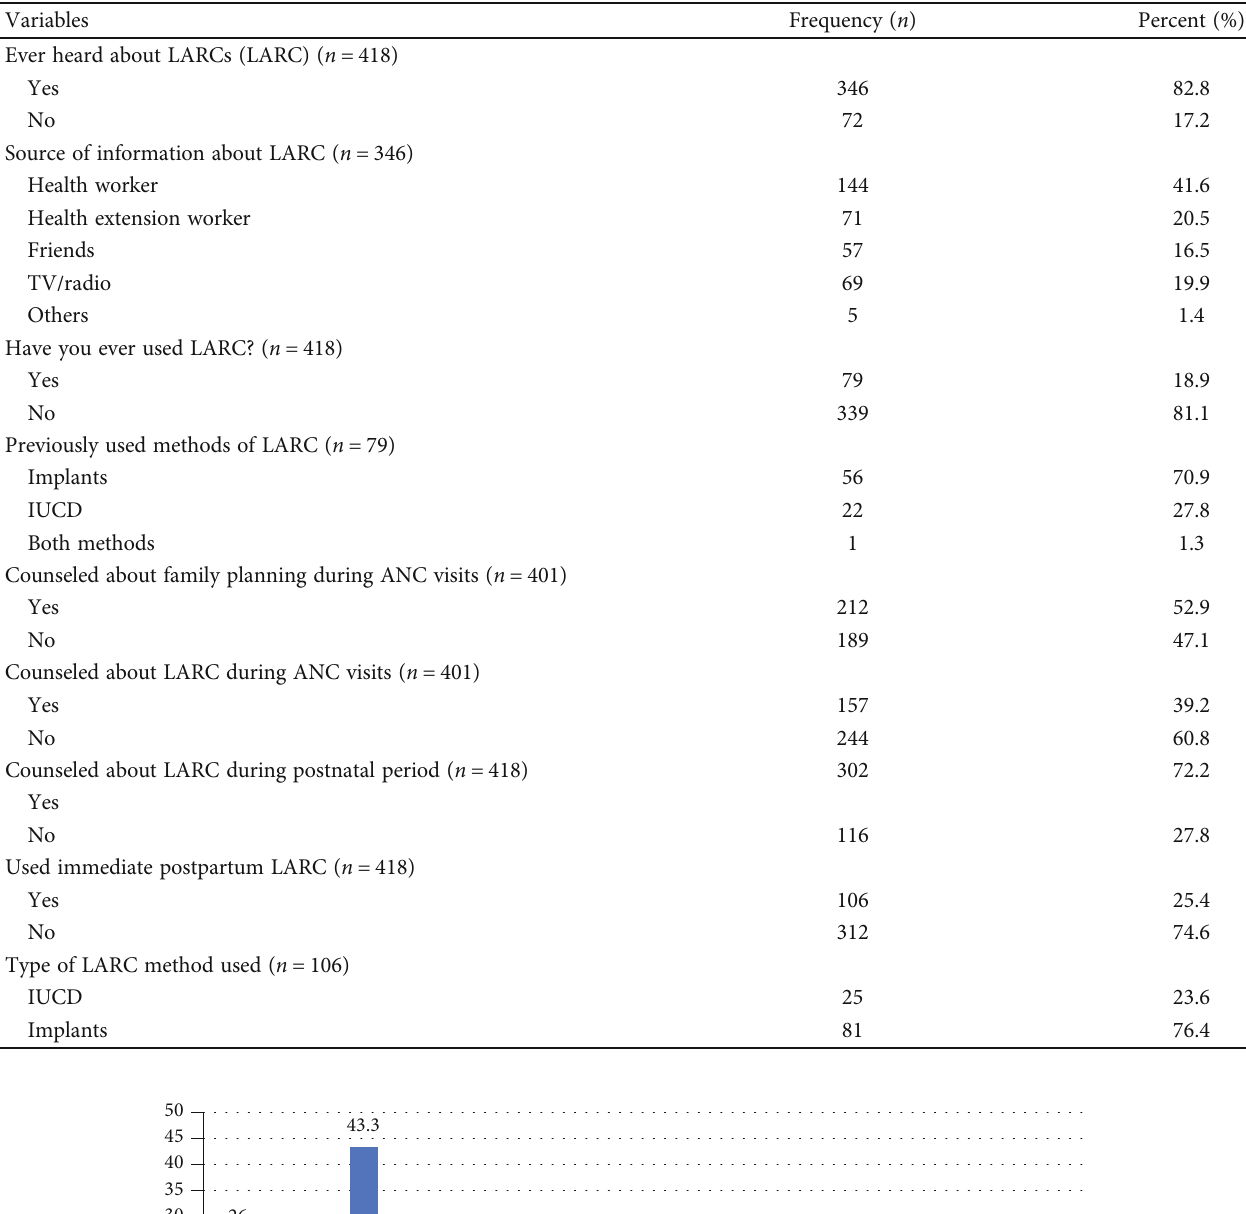
Table 3: Awareness and utilization of LARC methods among women who gave birth in HUCSH, Ethiopia, April 2019. Variables Frequency ( n )